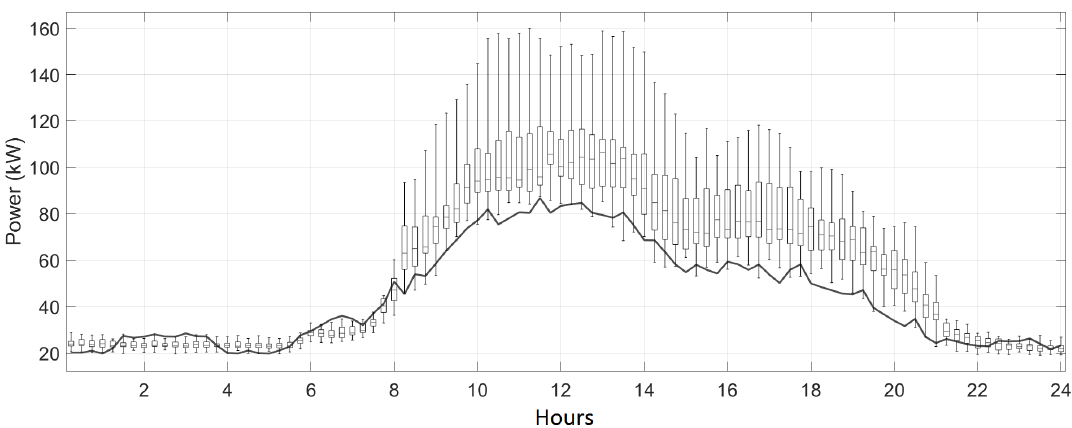
Figure 14. Analyzed Friday compared with the consumption pattern applying the seasonal filter method (SF).